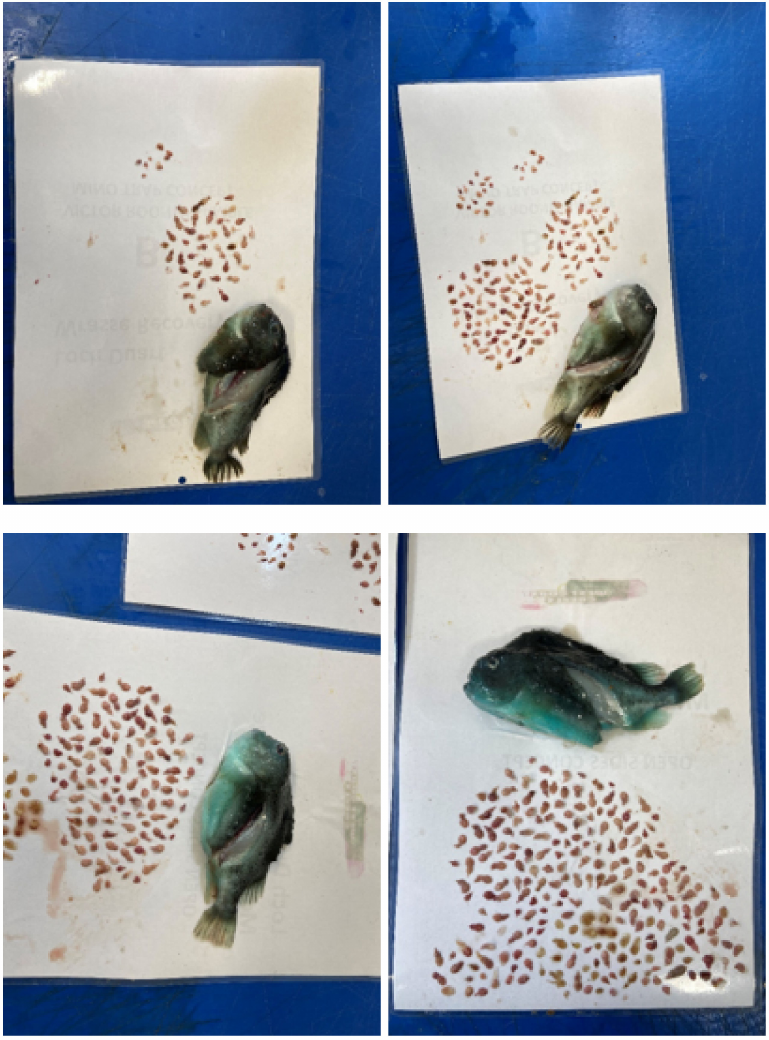
Figure 8. Gut content of stocked lumpfish from Scotland. Samples were taken during a harvest operation, on 16 July 2021. Fish samples were varied, but all fish were above 100 g and in good health. They were transferred into sea cages on 9 February 2021 at an average weight of 30 g and at a rate of 9–11% stocking density. All lice seen in the picture are L. salmonis. Photos: L. Bennett, Cleaner fish Manager, Loch